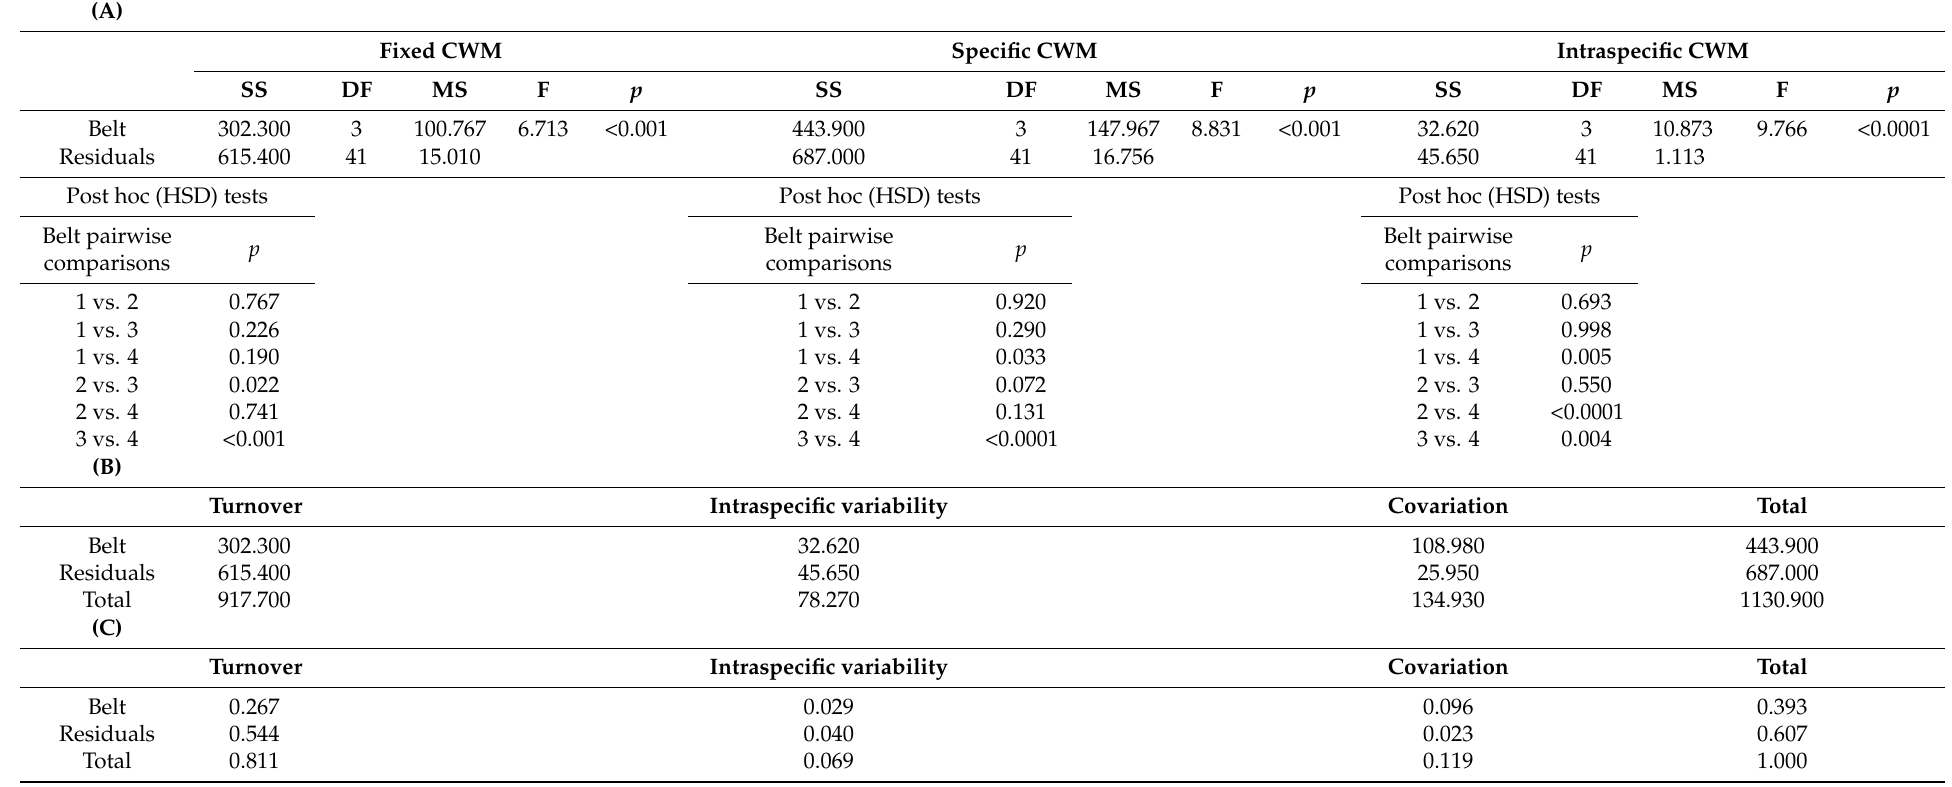
Table 1. Results of ANOVAs for CWM of plant height (H). ( A ) ‘Fixed’ and ‘specific’ averages and intraspecific variability effect were analyzed separately (one-way ANOVA), followed by post hoc (HSD) tests for pairwise comparisons. Note that the sum of squares (SS) corresponds to the amount of variability. DF = degrees of freedom, MS = mean of squares, F = Fisher’s F, p = probability. ( B ) Variability of individual components of trait variation (turnover, intraspecific and their covariation) between belts. Note that turnover, intraspecific variability and total variation are identical to SS columns in the ANOVA for fixed traits, intraspecific variability and specific traits, respectively. Covariation was obtained by subtracting the first two columns from the last. ( C ) Proportions of variability of individual components and their parts explained by elevation (belt). Note that the matrix was obtained from matrix B by dividing all of its elements by total SS for total variation, i.e., for specific